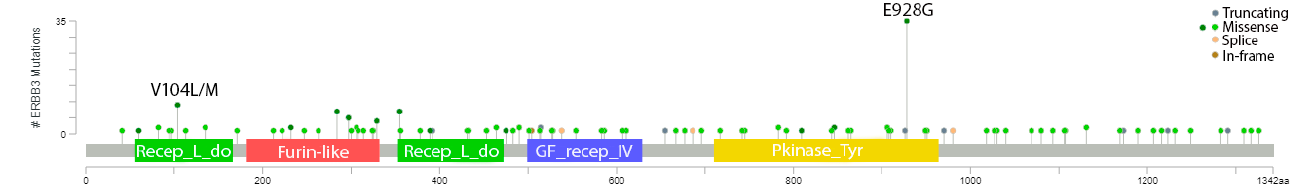
Figure 4. The frequency of HER3 mutations in breast cancer and their locations within the receptor. Figure rendered in cBioPortal using multiple studies (n = 8615). Gray indicates truncating mutation, green indicates a missense mutation, yellow indicates splice mutation, and brown indicates an in-frame mutation [27,28] .